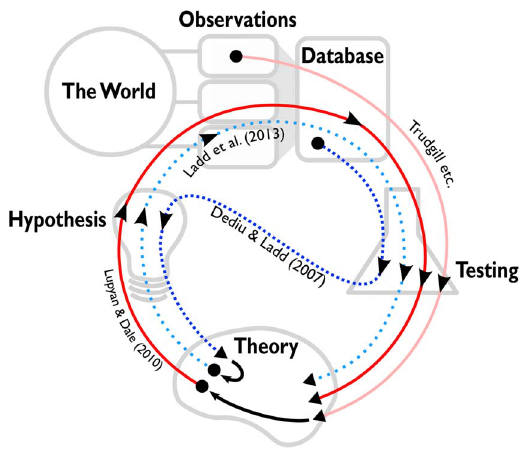
Figure 1. The scientific processes of different nomothetic studies. Observations are drawn from the world, either as idiographic studies or experiments. These observations can be compiled into large- scale cross-cultural databases. Scientific elements include theory, hypotheses and testing. Trajectories indicate the process of different studies. Processes start at a dot and continue in the direction indicated by the arrows. The ideal trajectory is the following: A theory generates a hypothesis. The hypothesis suggests data to collect, which is then tested. The results of the test feed back into the theory. Lupyan & Dale (2010) follow this trajectory, although they take their data from a large- scale cross-cultural database. Lupyan & Dale’s theory was generated by previous testing of (small-scale) observations by Trudgill and others. The trajectory of Dediu & Ladd’s study differs in two ways. First, the trajectory starts with large-scale cross-cultural data rather than small- scale observations. Secondly, the testing generates the hypothesis, which suggests a theory. However, Ladd et al. (2013) use this theory to motivate a hypothesis which is tested on experimental data. Since developing theories from small-scale observations takes time and effort, Dediu & Ladd’s study has effectively jump-started the conventional scientific process.